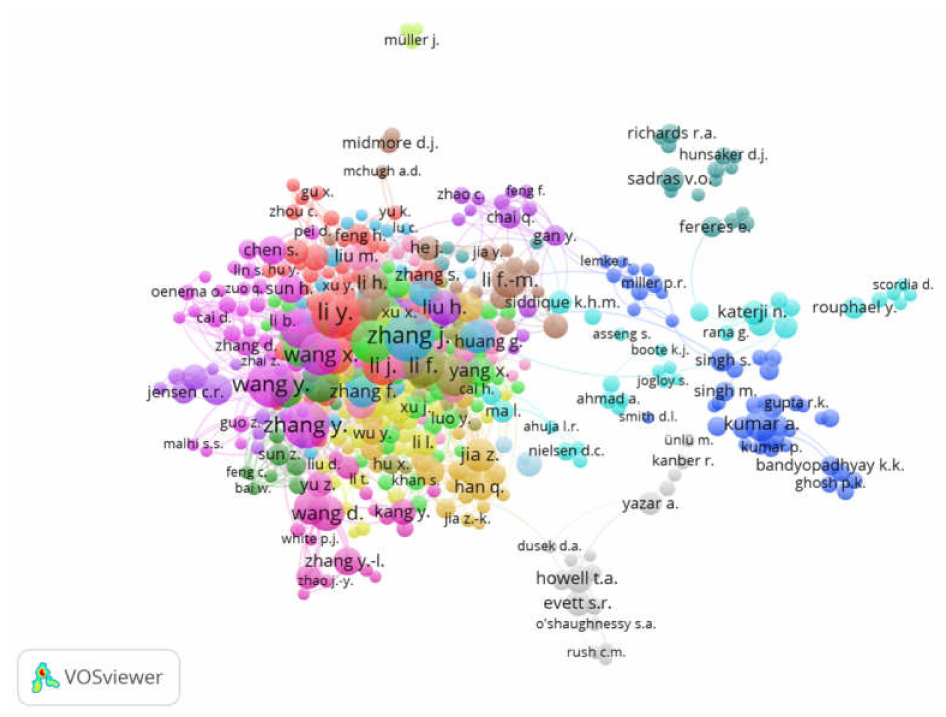
Figure 5. Cooperation based on co-authorship between authors for